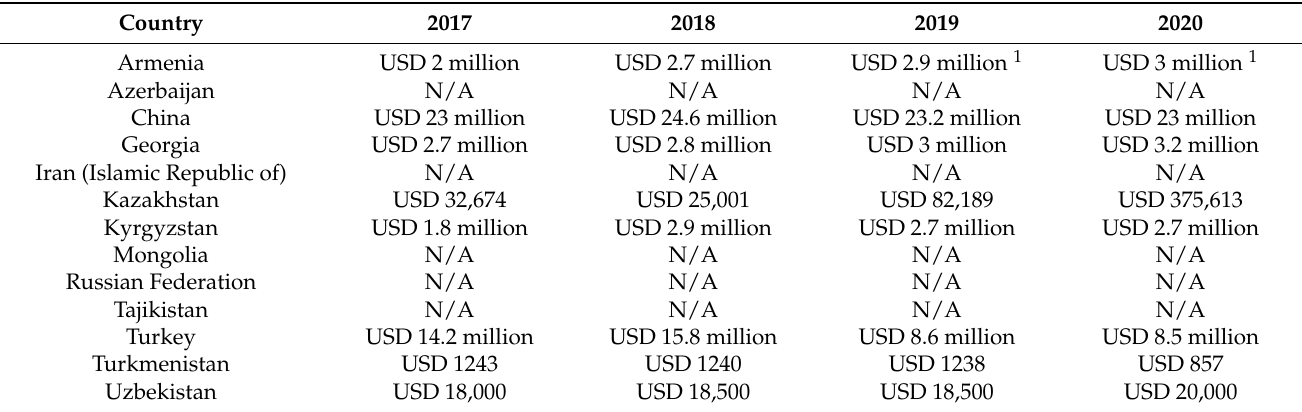
Table 2. Reported national budgets for activities related to PPR in 2017–2020. Figures originally given in local currency are provided in USD (according to the exchange rate on 1st January of the respective year). Unless other donors are specified in the footnotes, all funds came from government sources. N/A indicates not